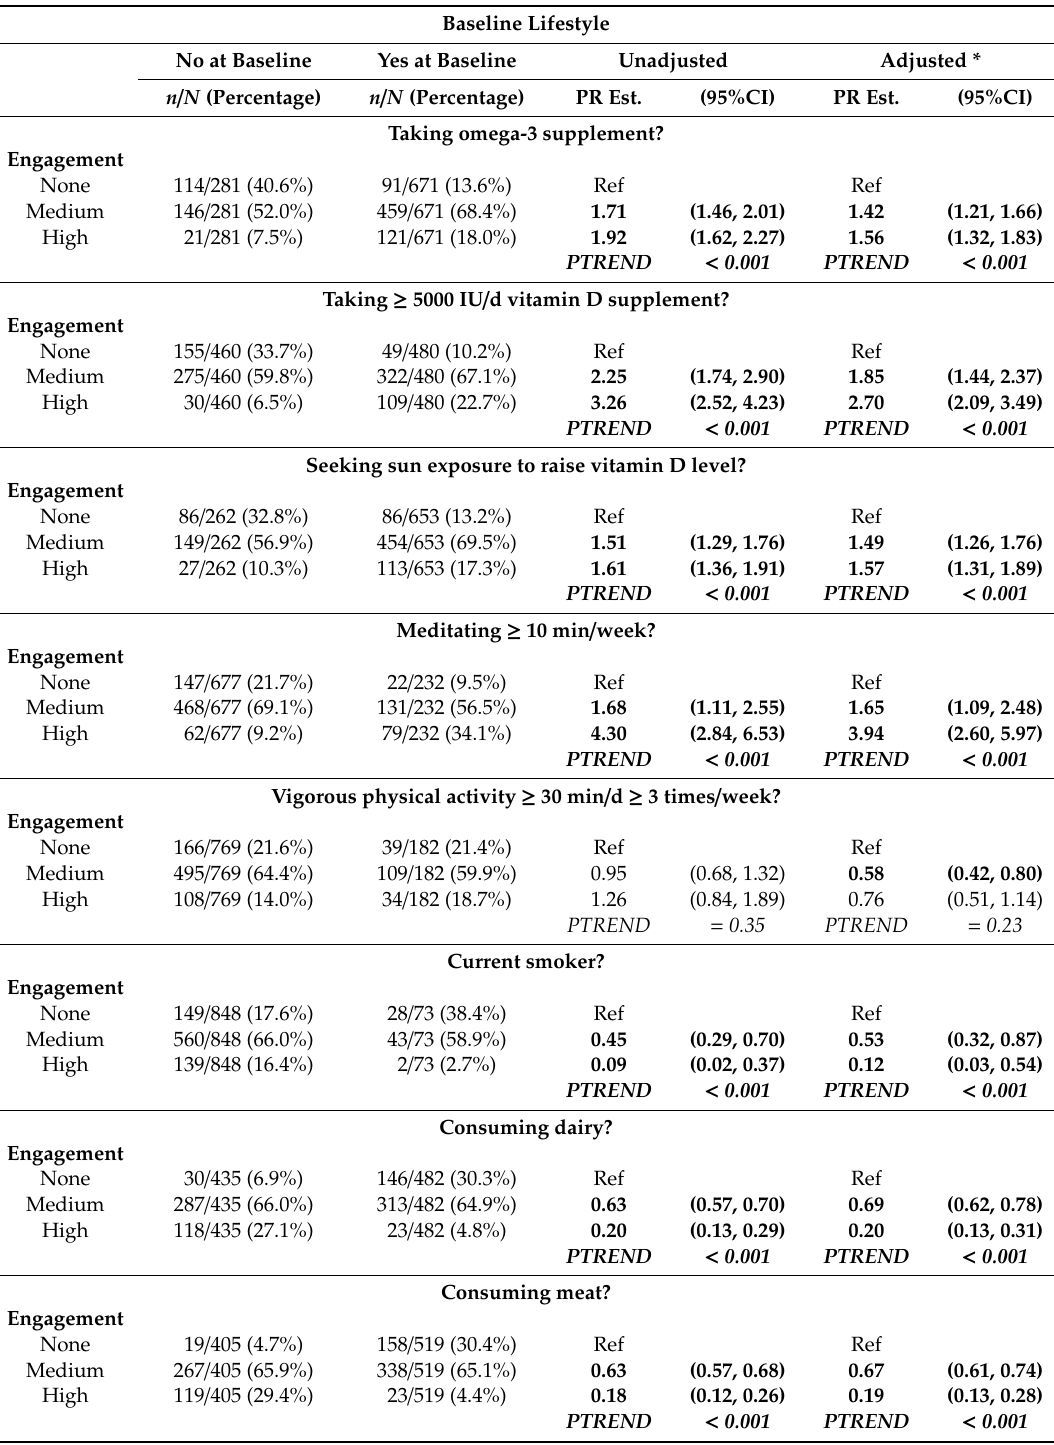
Table 3. Baseline associations of lifestyle with resource